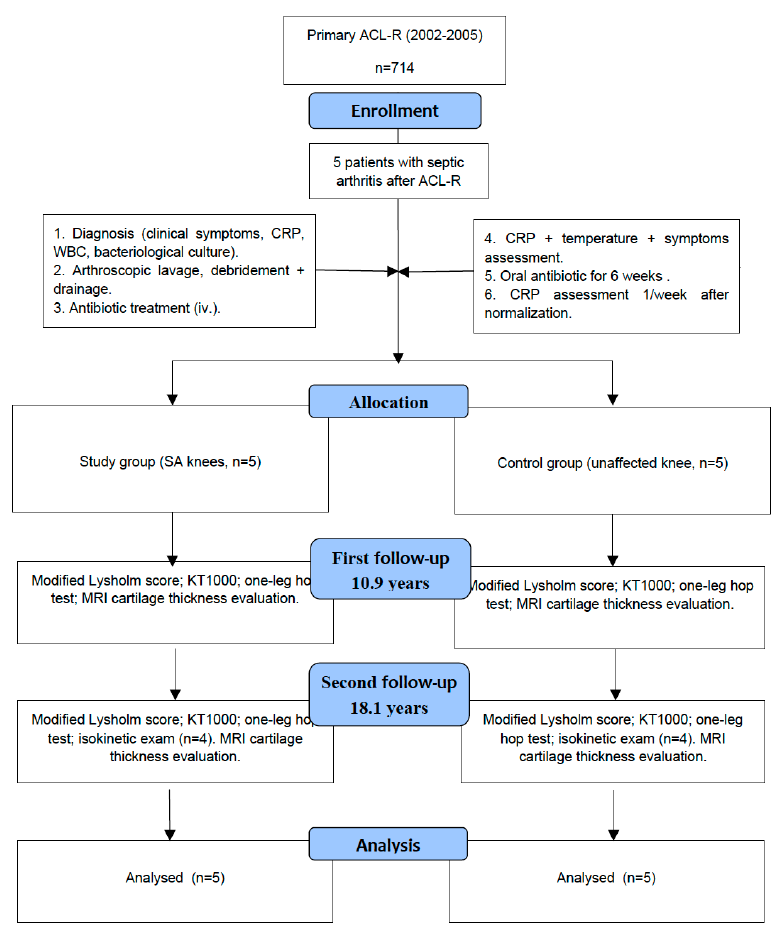
Figure 1. Participant flow.